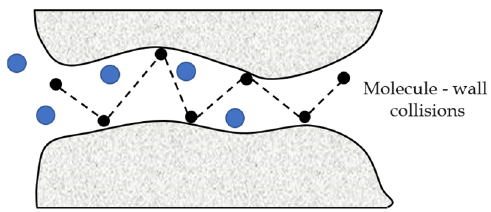
Figure 2. A schematic diagram of the Knudsen